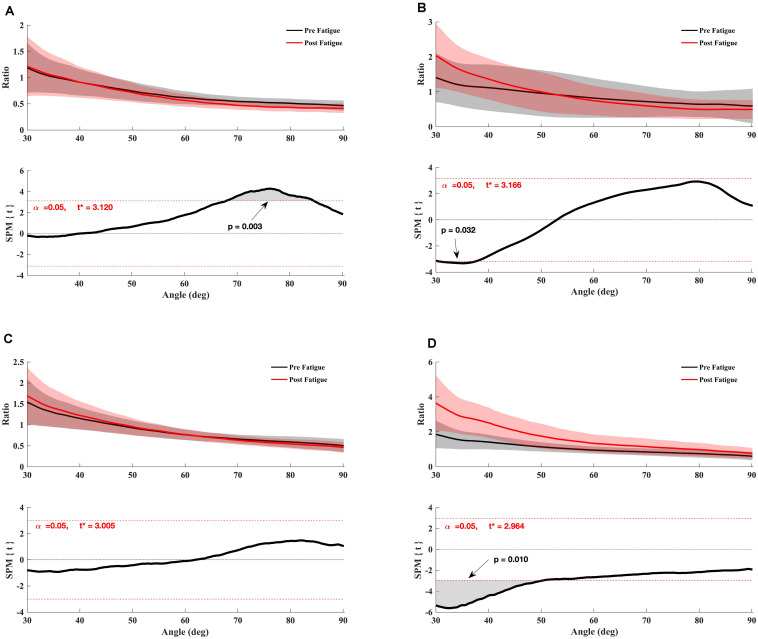
Effect of fatigue on the angle-specific ratio. (A) H/Qconv90θ, (B) H/Qconv180θ, (C) H/Qfunc90θ, (D) H/Qfunc180θ. Mean ± 95% confidence interval angle-series (upper panel) and corresponding SPM vector field statistical analysis (lower panel). The red dotted line represents the critical random field, the threshold value, t statistical set for α = 0.05. The p < 0.05 portion of the curve is shaded in gray.